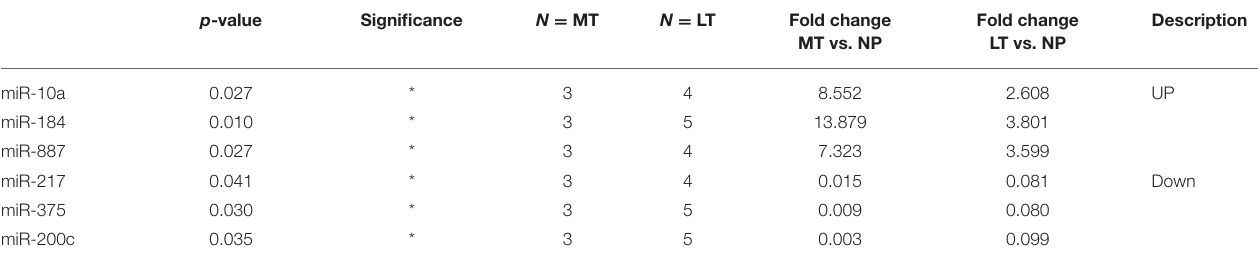
TABLE 3 | Validation of differentially expression of six microRNAs in metastatic ( n = 3) and localized tumors ( N = 5). p -value Significance N = MT N = LT Fold change